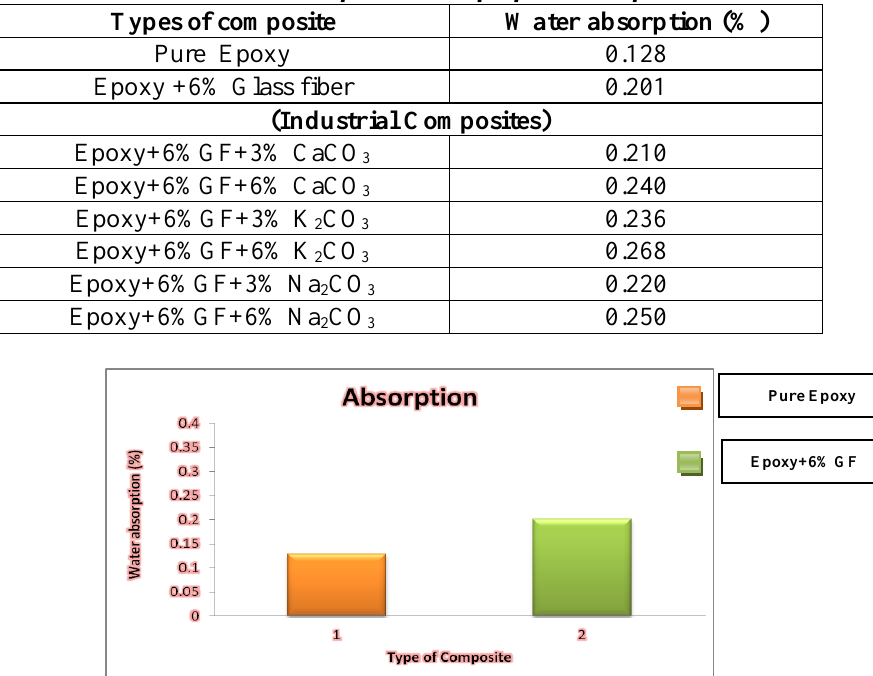
Fig.10: Water absorption of Epoxy +6% glass fiber composites and pure